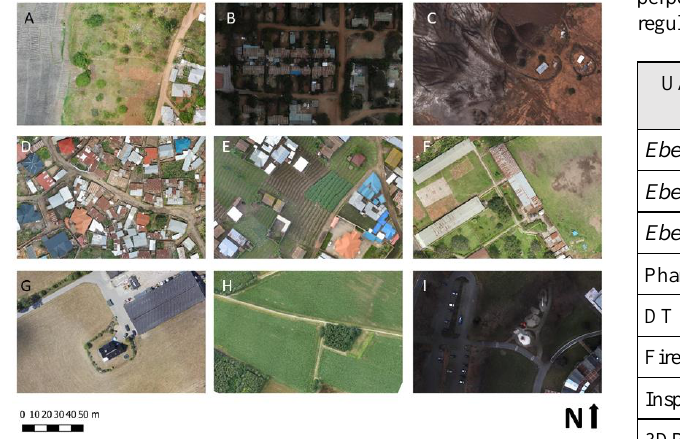
Figure 1: Overview of study areas with examples from generated orthomosaics. A) Kibonde Mzungu (Tanzania - Zanzibar), B) Kajiado (Kenya), C) Mailua (Kenia), D) Muhoza (Rwanda), E) Busogo (Rwanda), F) Ruhengeri (Rwanda), G) Bentelo (The Netherlands), H) Amtsvenn (Germany), I)